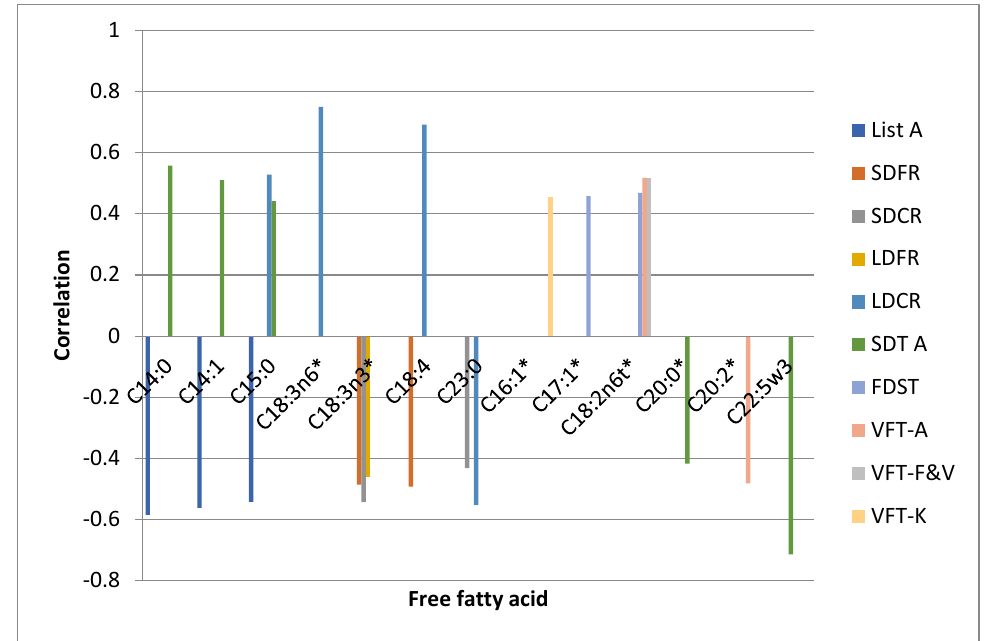
Figure 3. Correlations between FFAs and neuropsychological test scores performed after 6 months. * statistically significant differences between the FFA level in the control and experimental group.